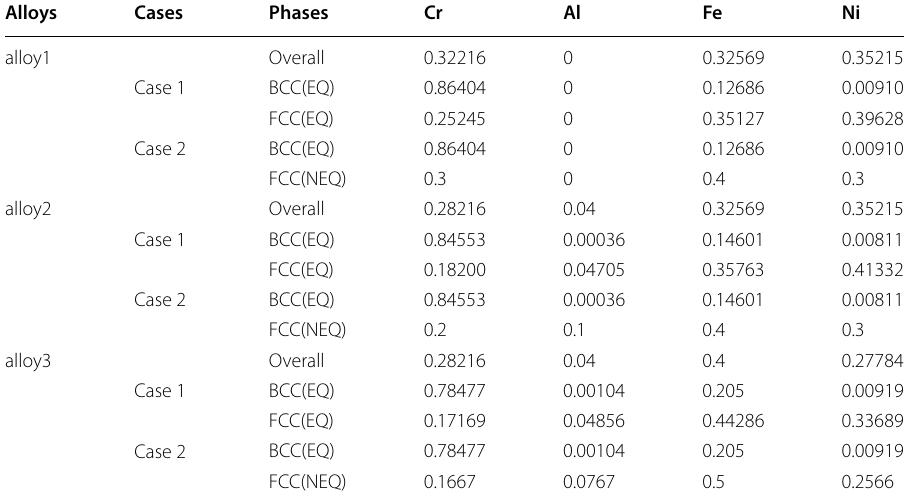
Table 6 Initial composition for BCC and FCC phases for the three different alloys considered in the simulations and assuming equilibrium(EQ) and nonequilibrium(NEQ) composition of the matrix as initial setting of the